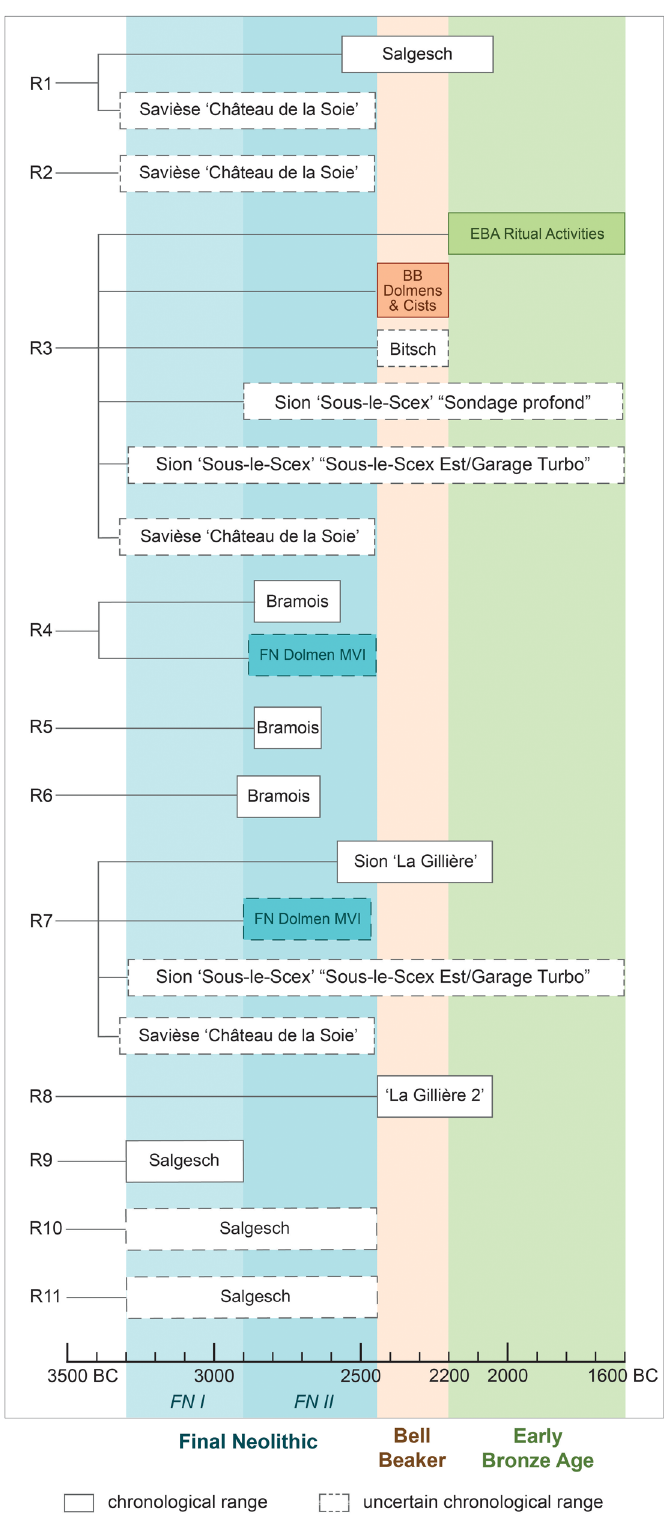
Figure 12: Chronology of the paste preparation recipes ( R ) listed in Table 6. The chronological ranges are determined basing on the radiocarbon dates and stratigraphic data available for the recovering context of each pottery sample ( see Supplementary material 1 and Section 2 )